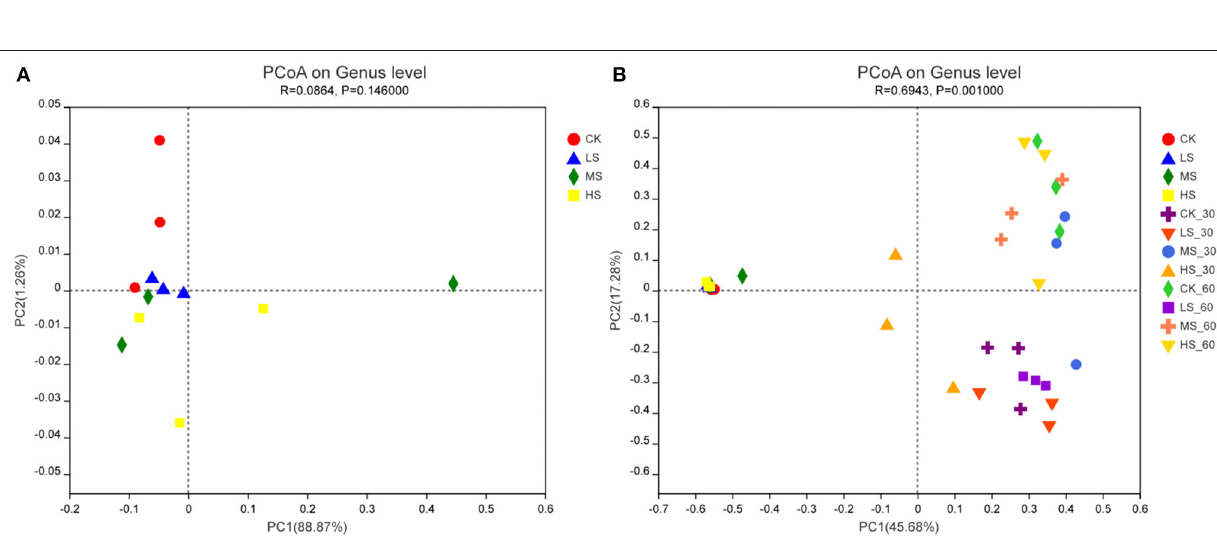
FIGURE 5 | (A,B) Principal co-ordinates analysis (PCoA) of bacterial communities in alfalfa silage. CK, fresh material of alfalfa without salt stress; LS, alfalfa under light salt stress; MS, alfalfa under moderate salt stress; HS, alfalfa under severe salt stress; 30, 30 days of ensiling; 60, 60 days of